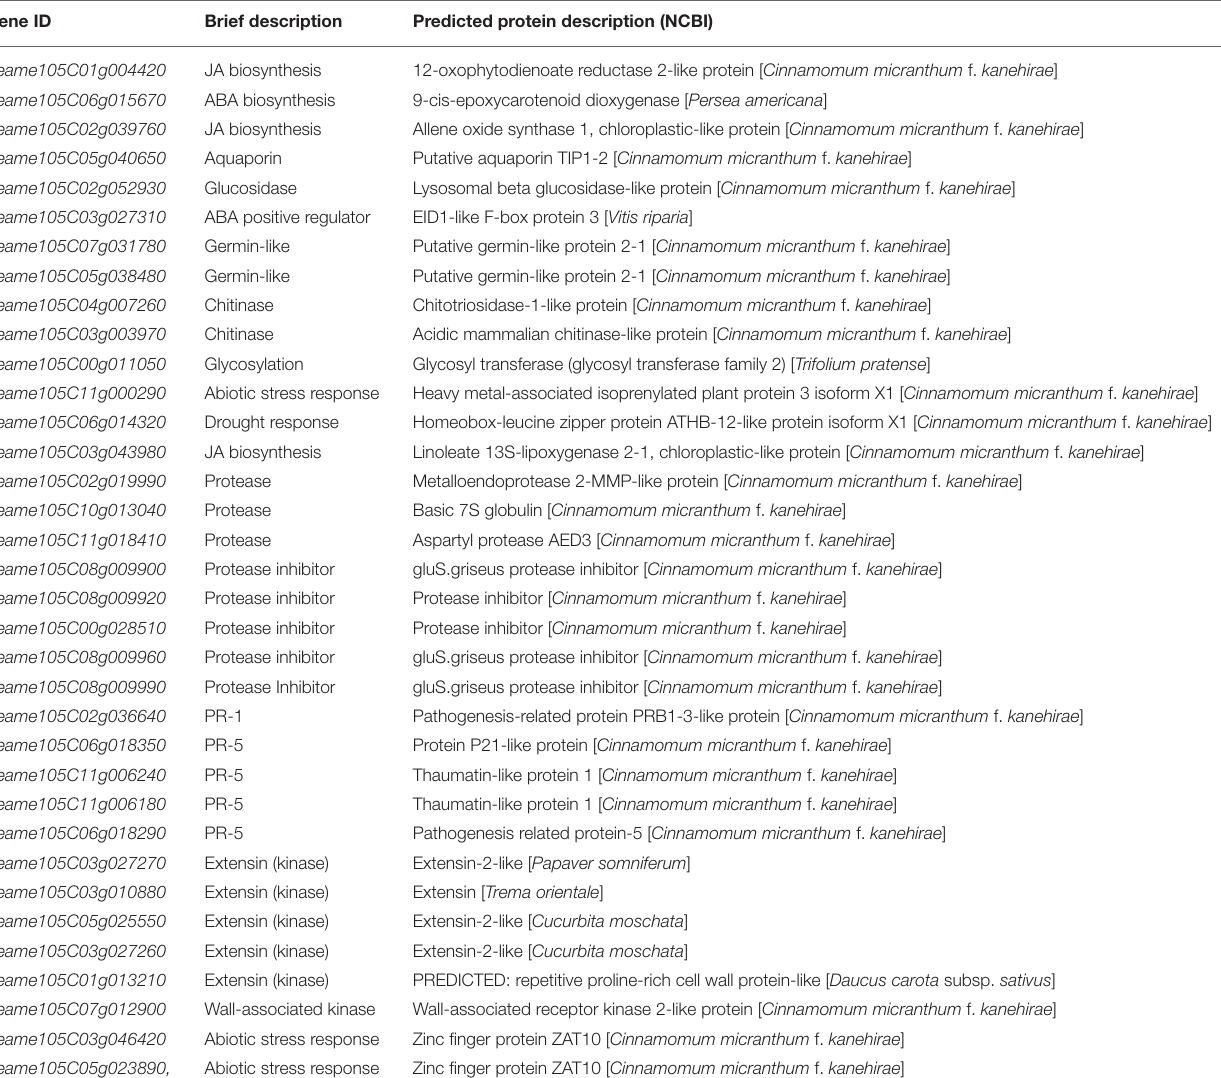
TABLE 3 | Filtered list of the most variably expressed defense- and stress-related genes between R0.12 and Dusa ® following P. cinnamomi inoculation. Gene ID